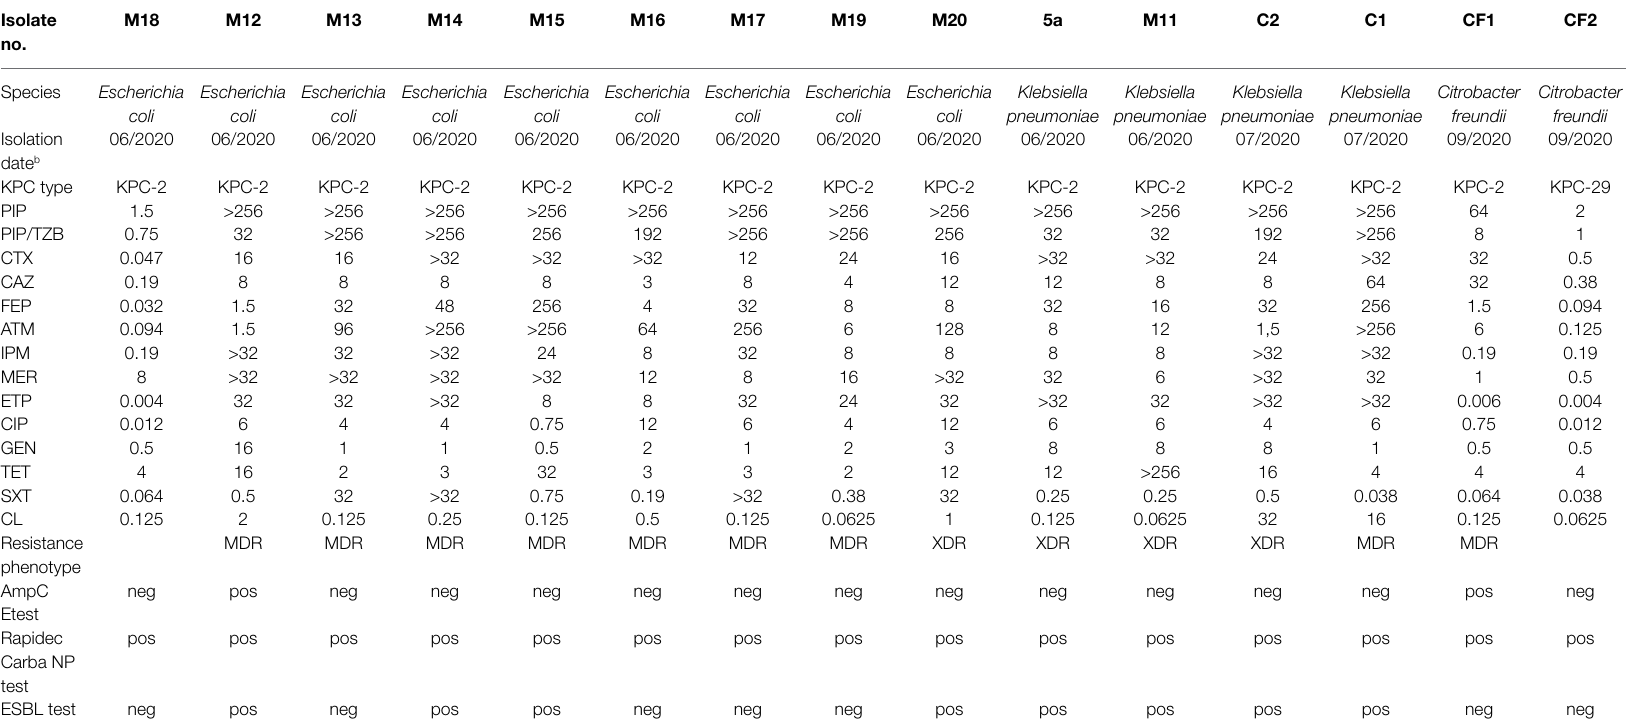
TABLE 1 | Antibiotic resistance profiles of 15 KPC-producing Enterobacteriaceae isolates recovered in this study a . Isolate